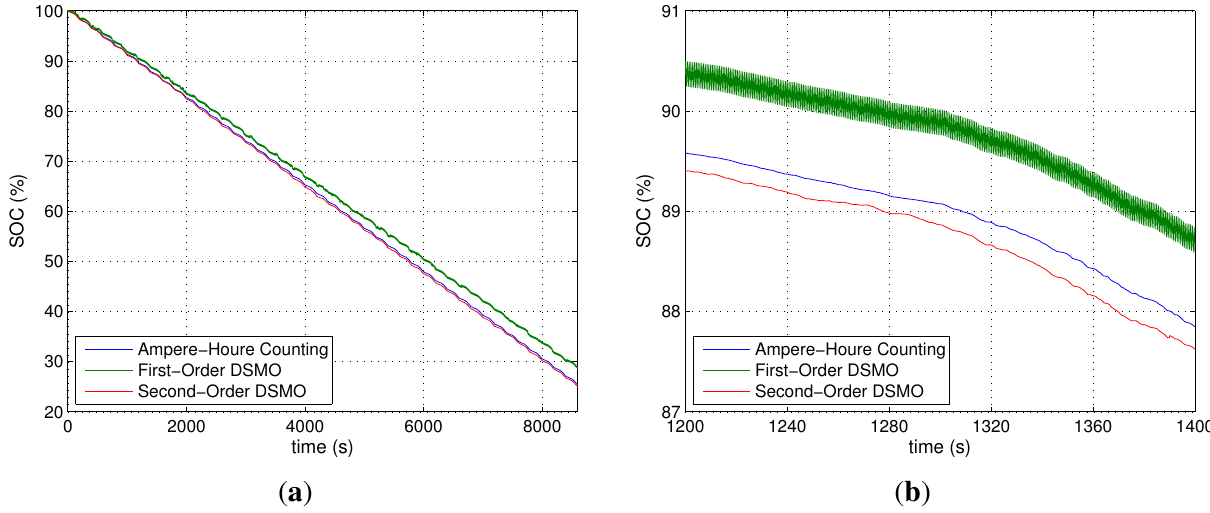
Figure 8. SOC estimation results for the proposed